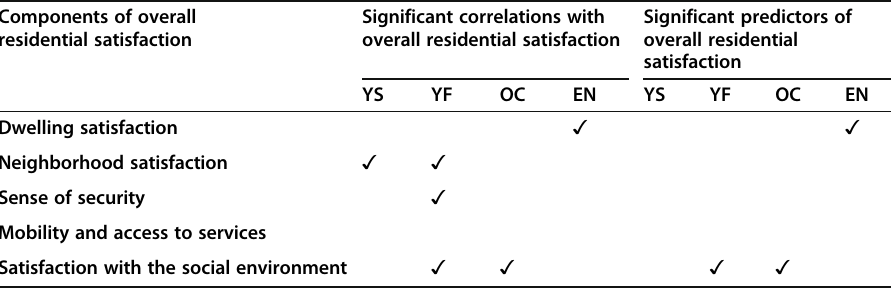
Table 17 Most important predictors of overall residential satisfaction for the different life cycle